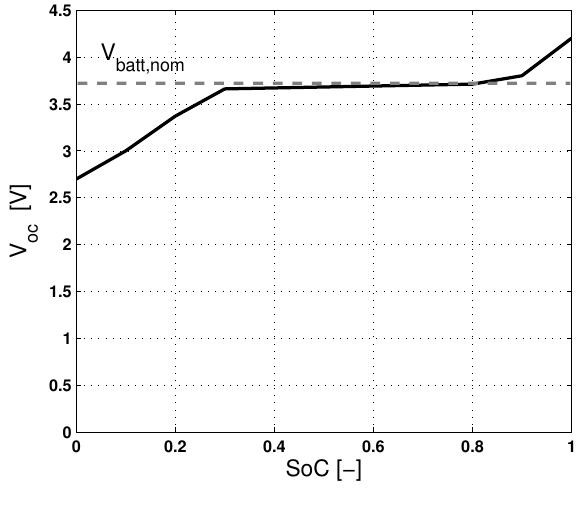
Figure 4. Battery open circuit